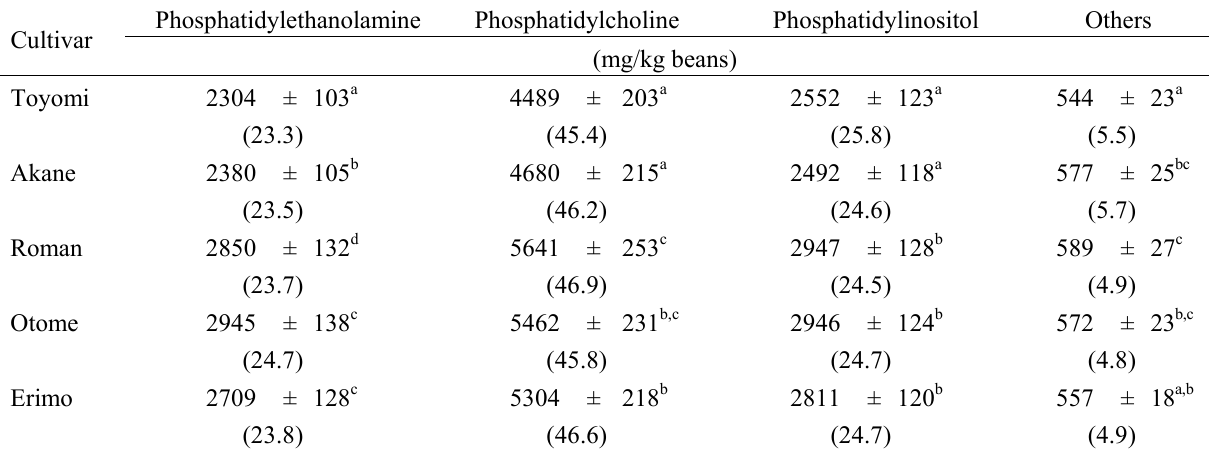
Table 1. The content of major phospholipids in the oils obtained from adzuki beans